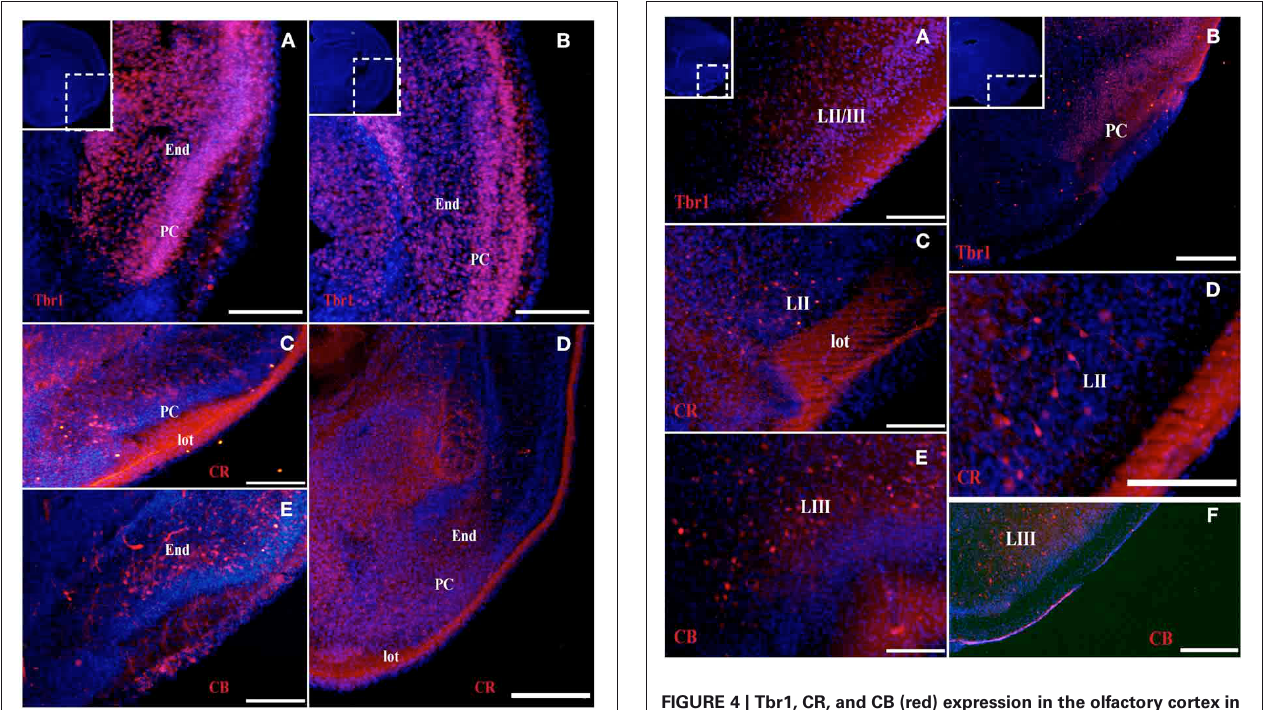
FIGURE 4 | Tbr1, CR, and CB (red) expression in the olfactory cortex in adult mice. (A,B) Tbr1 expression in layers II and III of the PC. (C,D) CR is expressed in layer II of the PC and in the lot. (E,F) CB expression is restricted to the layer III in the piriform cortex. Coronal sections ; midline is to the left and dorsal is up. Blue corresponds to the bisbenzimide counterstaining. Scale bars: 500 µ